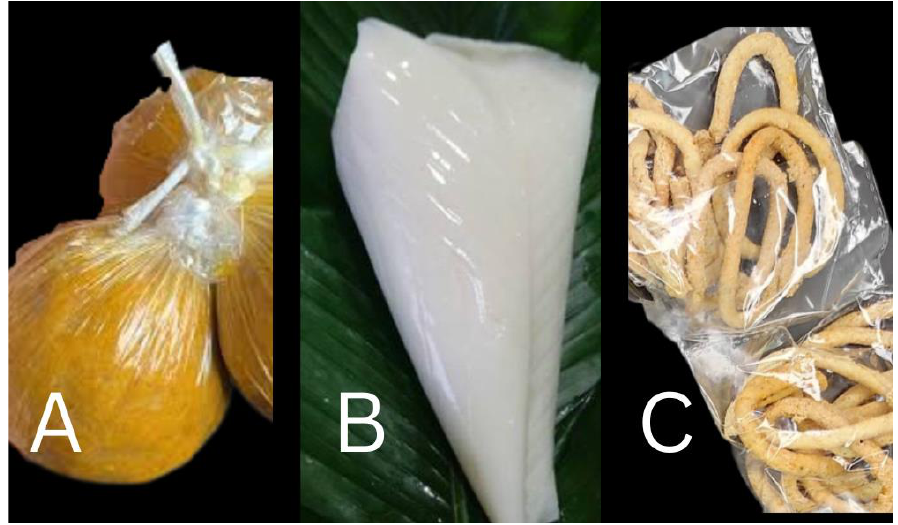
Figure 1. A pictorial representation of artisanal produced ready-to-eat foods. ( A ) Aadun , ( B ) eko , ( C ) kokoro.